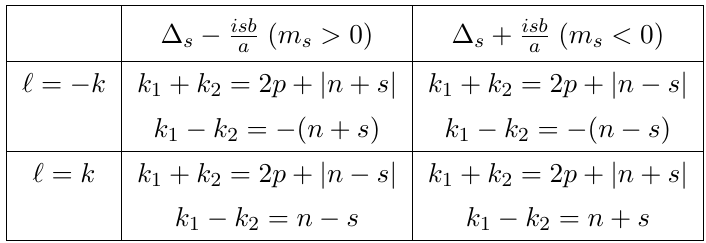
to the Selberg a